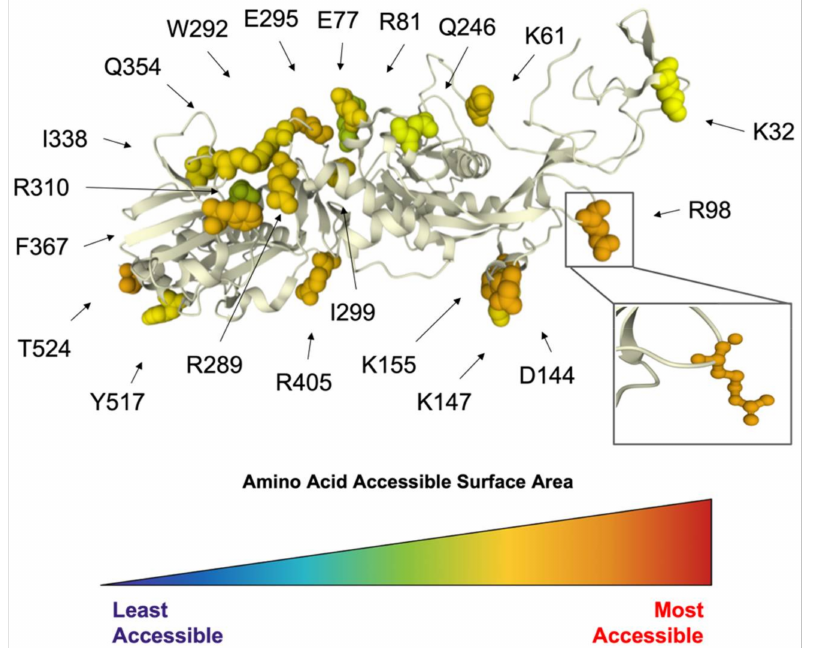
Figure 8. Conserved and accessible amino acids of CoV exonuclease. Identified conserved and accessible residues within coronavirus exonuclease highlighted with molecular surface representation and colored by amino acid ASA ranging from the least accessible (dark blue) to the most accessible (red) in the Nsp14 crystal structure (PDB ID: 5C8U). Twenty of the most accessible residues are highlighted, with R98 being the most